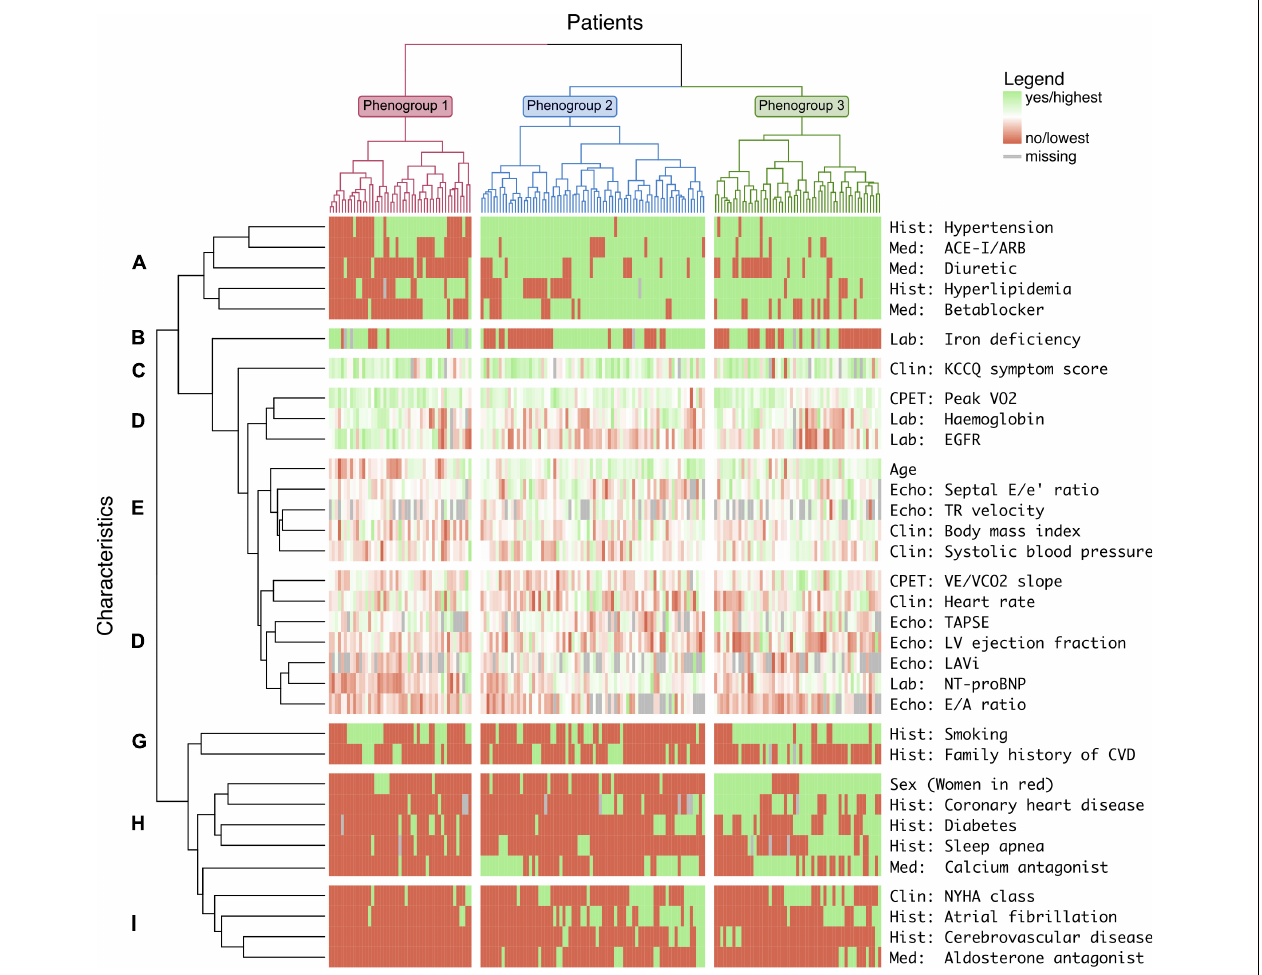
FIGURE 2 | Three phenogroups of patients with HFpEF identified through machine learning and their characteristics. Heatmap with columns representing individual patients and rows representing individual characteristics, both grouped in clusters by unsupervised machine learning. Three phenogroups (numbers 1–3) and 9 characteristics clusters (letters A–I) were distinguished. ACE, angiotensin-converting enzyme; ARB, angiotensin receptor blocker; Clin, clinical examination; CVD, cardiovascular disease; Echo, echocardiography; EGFR, estimated glomerular filtration rate; Hist, medical history; KCCQ, Kansas City Cardiomyopathy Questionnaire; LAVi, left atrial volume index; LV, left ventricular; Med, current medication; NT-proBNP, N -terminal pro-B-type natriuretic peptide; NYHA, New York Heart Association; TAPSE, tricuspid annular plane systolic excursion; TR, tricuspid regurgitation; ˙VCO 2 , carbon dioxide production; ˙VE, ventilation; ˙VO 2 ,